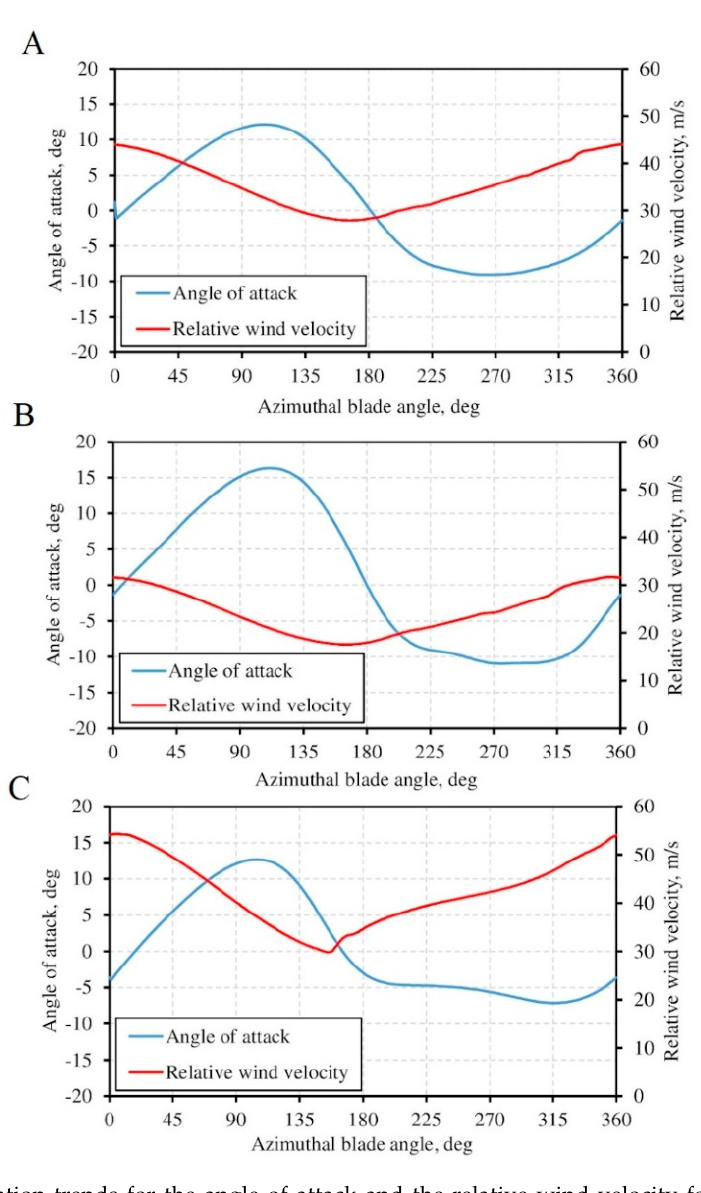
Figure 4. Variation trends for the angle of attack and the relative wind velocity for the selected study cases.